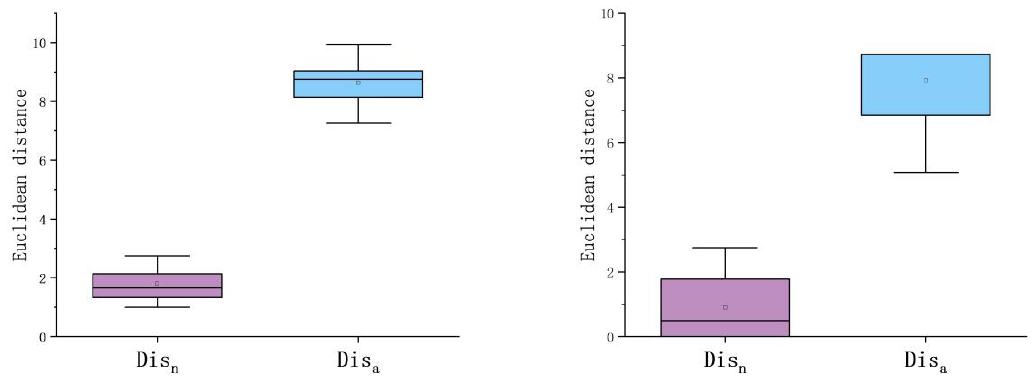
Figure 5. Embedding analysis (on the CICIDS17 dataset) is shown on the left on the training set and on the right on the test set.